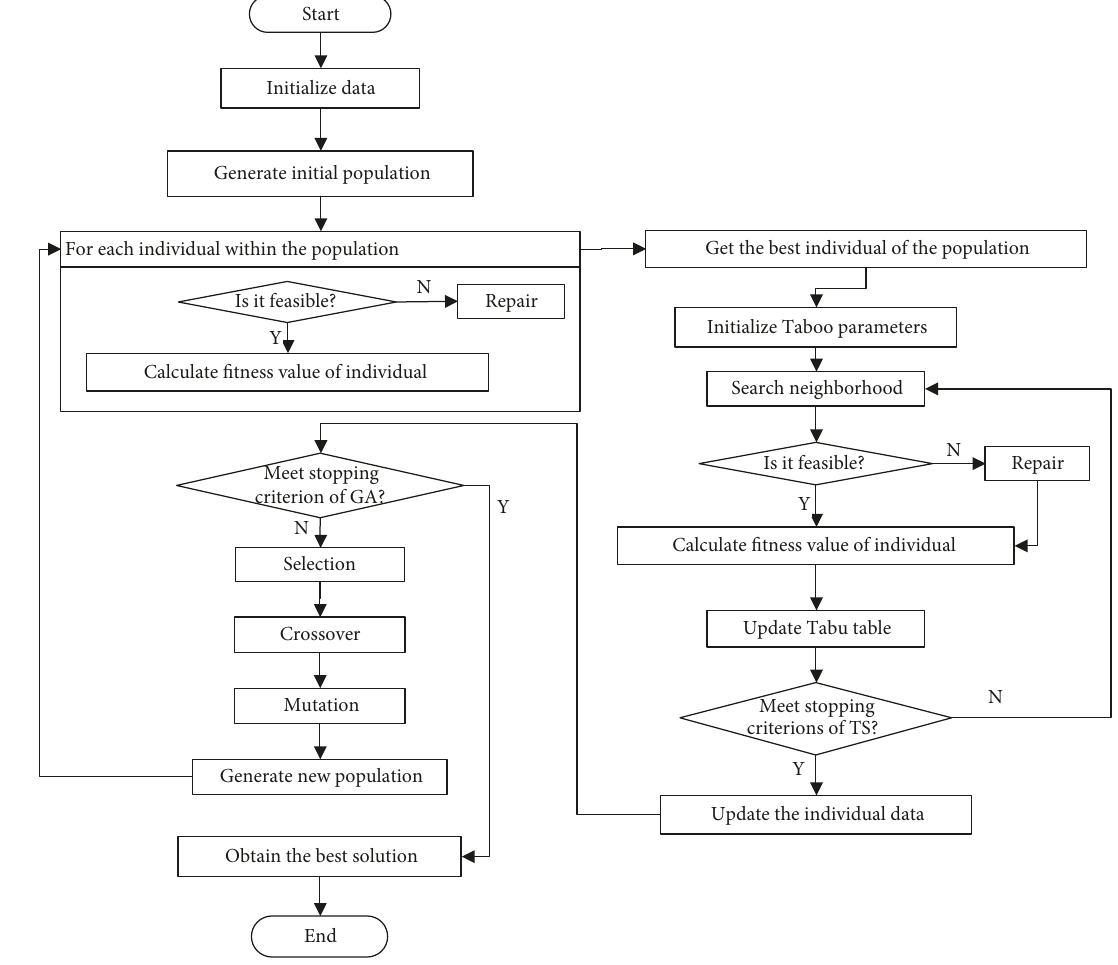
Figure 2: Flow chart of the proposed algorithm of block transportation scheduling.